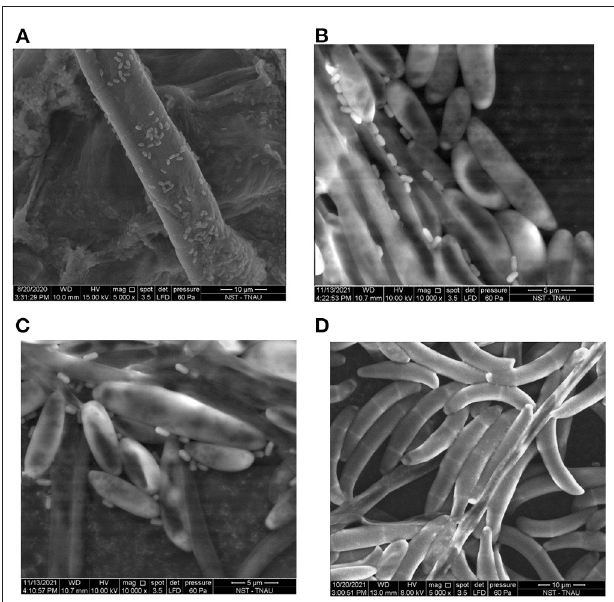
FIGURE 4 | (A) Colonization of Bacillus velezensis YEBBR6 in the root zone of biohardened banana plantlets. (B,C) Colonization of Bacillus velezensis YEBBR6 in the mycelium and microconidia of Foc KP on biohardened banana plantlets after challenge inoculation with Foc KP. (D) Colonization of micro and macroconidia in infected plantlets after challenge inoculation with Foc